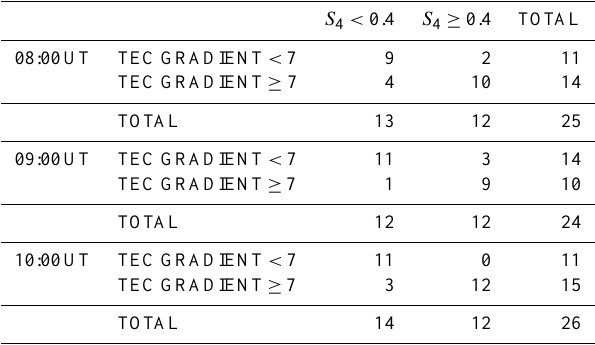
Table 3. 2 × 2 contingency table of the three stations (Calcutta, Ba- harampore, N.B.U. Siliguri) for testing the null hypothesis